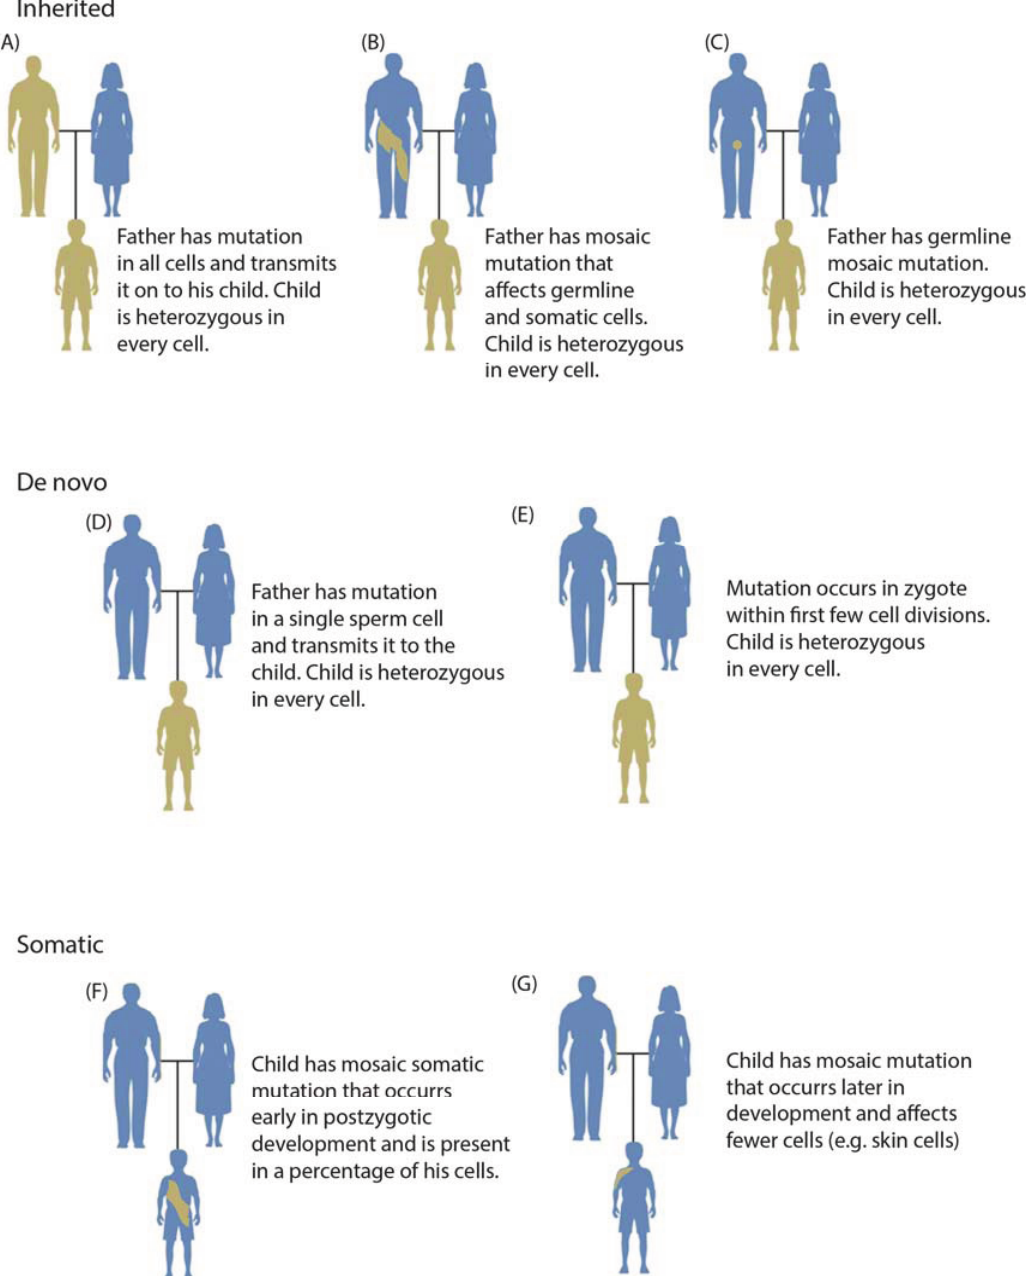
Figure 1. Overview of categories of variation including inherited (panels A–C), de novo (panels D,E), and somatic variation (panels F,G). Inherited mutations are always transmitted through the germline ( A ); although a parent may also have a mosaic mutation (this combination of somatic and germline mosaicism is occasionally termed gonadal mosaicism) ( B ); In such cases, a child may inherit the variant as a heterozygous mutation with a more severe clinical phenotype. A parent may also have germline mosaicism that may be inherited by progeny ( C ); De novo mutations are operationally defined as genotypes observed in a child but not in either parent. They may originate in a parental germ cell (as may be inferred in a pedigree having multiple affected offspring) ( D ) or postzygotically ( E ); Somatic mutation may occur relatively early in development ( F ) or at any later time throughout the lifespan ( G ), generally affecting fewer